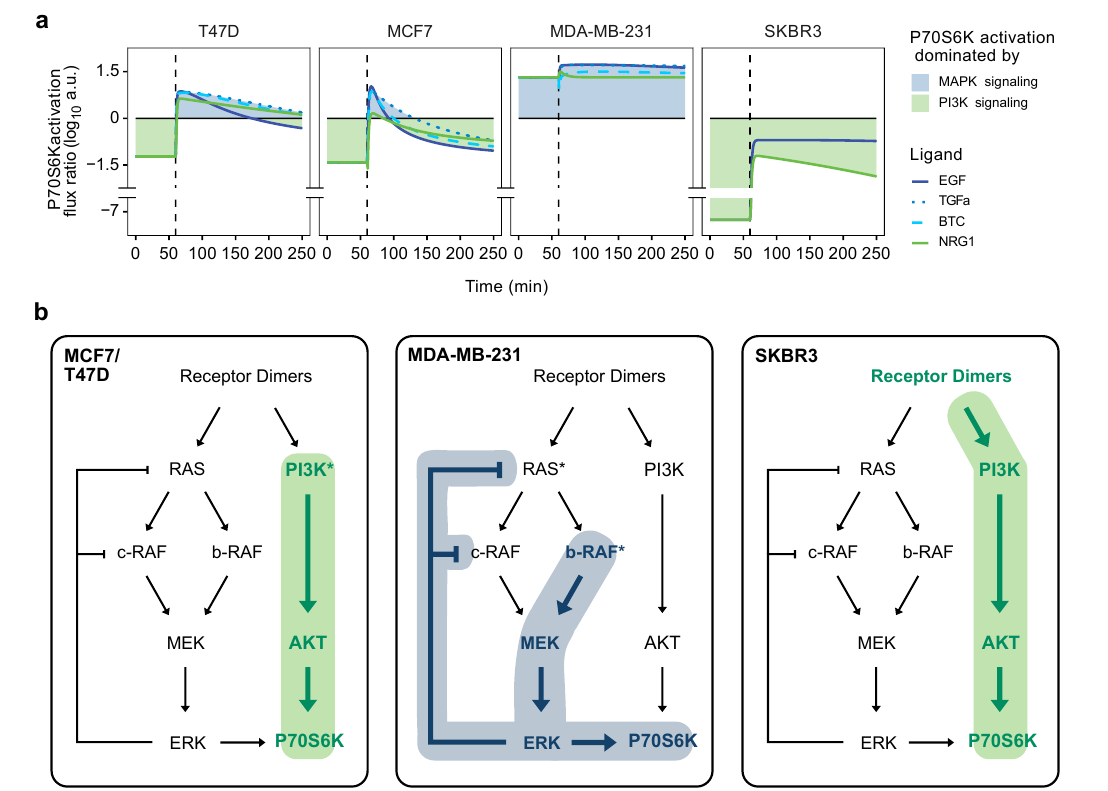
Figure 6. Signaling fluxes strongly differ between breast cancer cell lines. ( a ) The activation of the P70S6 kinase by MAPK and PI3K signaling pathways is depicted as the ratio of their respective activation fluxes over time. Line colors differentiate between ligands, whereas blue (MAPK) and green (PI3K) areas indicate the respective dominant pathway activating P70S6K. ( b ) Dominating signaling fluxes without any ligand or drug treatment, as supported by the data. PI3K signaling forms the main signaling branch in MCF7, T47D and SKBR3 (highlighted in green), while MAPK signaling dominates in MDA-MB-231 cells, including a negative feedback loop on c-RAF and RAS (highlighted in blue). Asterisks indicate activating mutations in the respective components (note: PIK3CA , component of the the PI3K complex, is mutated in MCF7 and